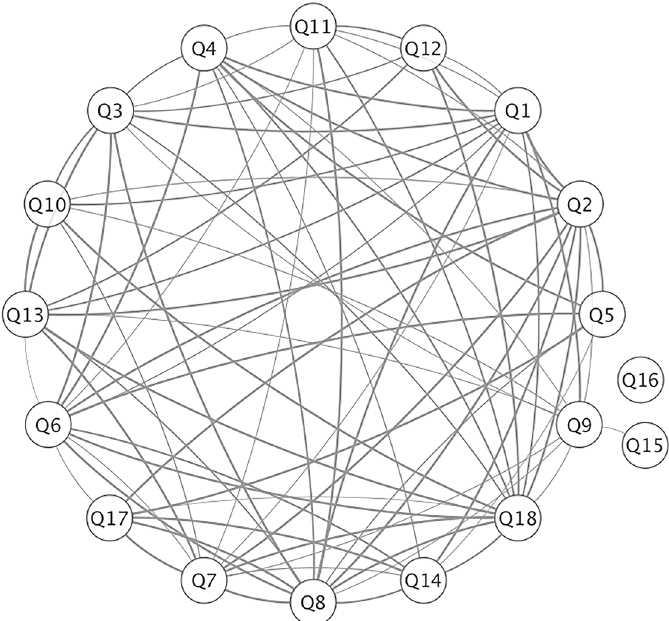
Fig 3. Q-Q similarity network based on common risk factors. The network consists of the 18 questions connected to each other with a criterion of q (cid:3) 0.01. Questions (circles) are connected by gray lines. The width of the edge reflects the significance of the q value. This network was visualized by Cytoscape